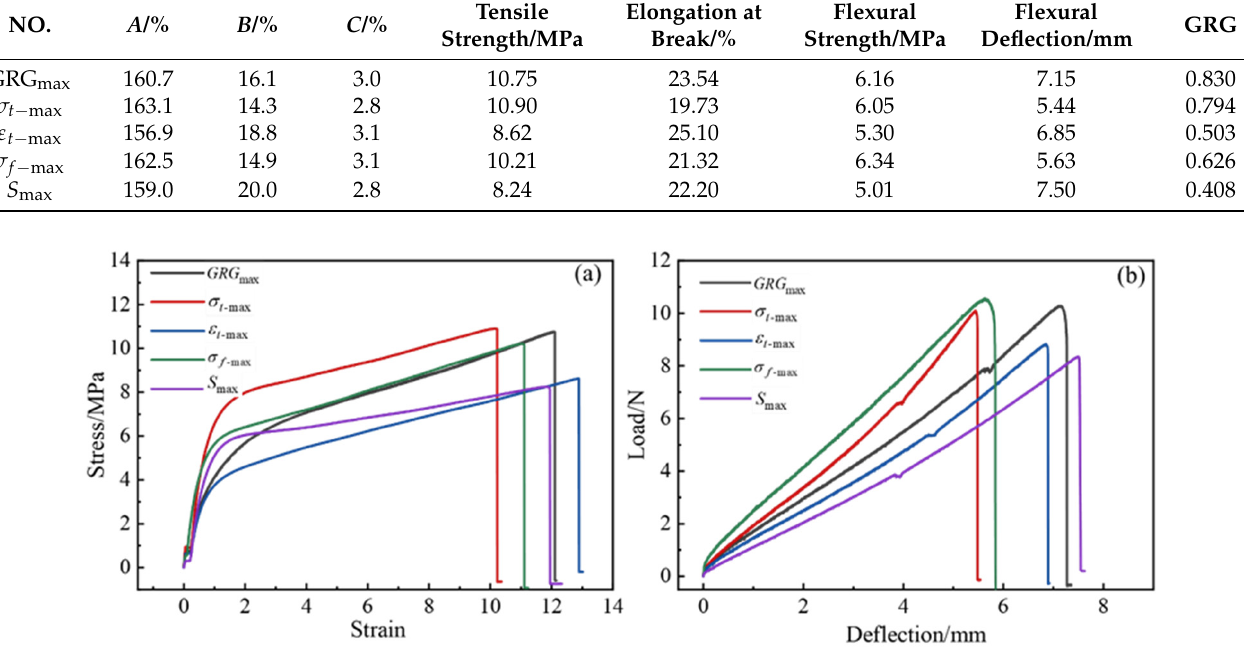
Figure 10. ( a ) Stress–strain curve of tensile test, ( b ) load–deflection curve of bending test. GRG max was compared to σ t − max , elongation at break increased by 19.31%, bending strength increased by 1.81%, and bending deflection increased by 31.43%. GRG max was compared to ε t − max , tensile strength increased by 24.70%, bending strength increased by 16.22%, and bending deflection increased by 4.38%. GRG max was compared to σ f − max , the tensile strength was increased by 5.29%, the elongation at break was increased by 10.41%, and the bending deflection was increased by 27.00%. GRG max was compared to S max , the tensile strength was improved by 30.46%, the elongation at break was improved by 6.04%, and the bending strength was improved by